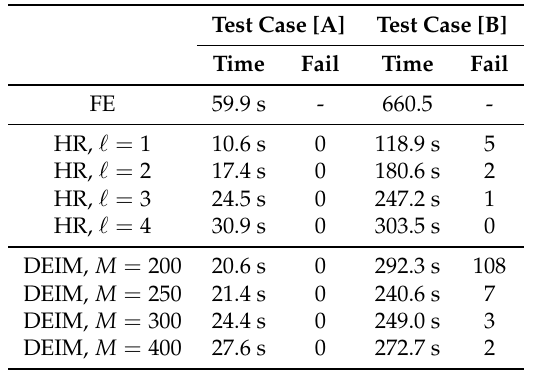
Table 4. Elapsed time and number of failures of the nonlinear solver for the solution of all computations of test case [A] (101 solves) and [B] (1000 solves) for Finite Element (FE), Hyper-Reduction (HR) with varying number of additional element layers (cid:96) points; all computations are carried out using N = 32 POD modes.